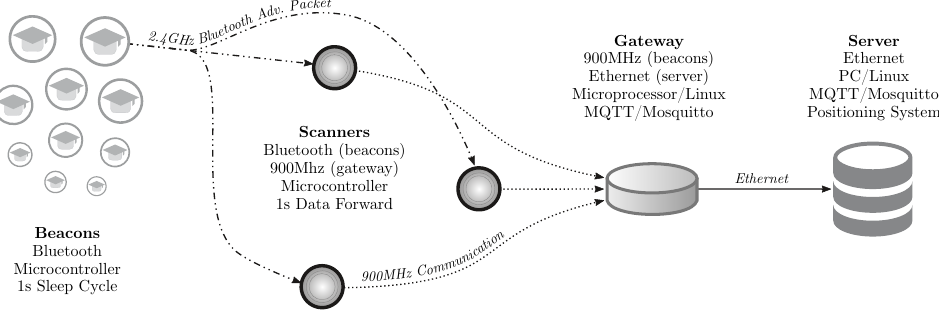
Figure 5. SmartCampus Architecture: a complete, large-scale, indoor positioning system testbed. All beacons send a Bluetooth advertisement packet every second. These packets are received by the scanners, which forward the data to the gateway using a 900 MHz, long-range, communication. The gateway sends the data to the central server, which can localize all of the beacons using the proposed graph-based technique.